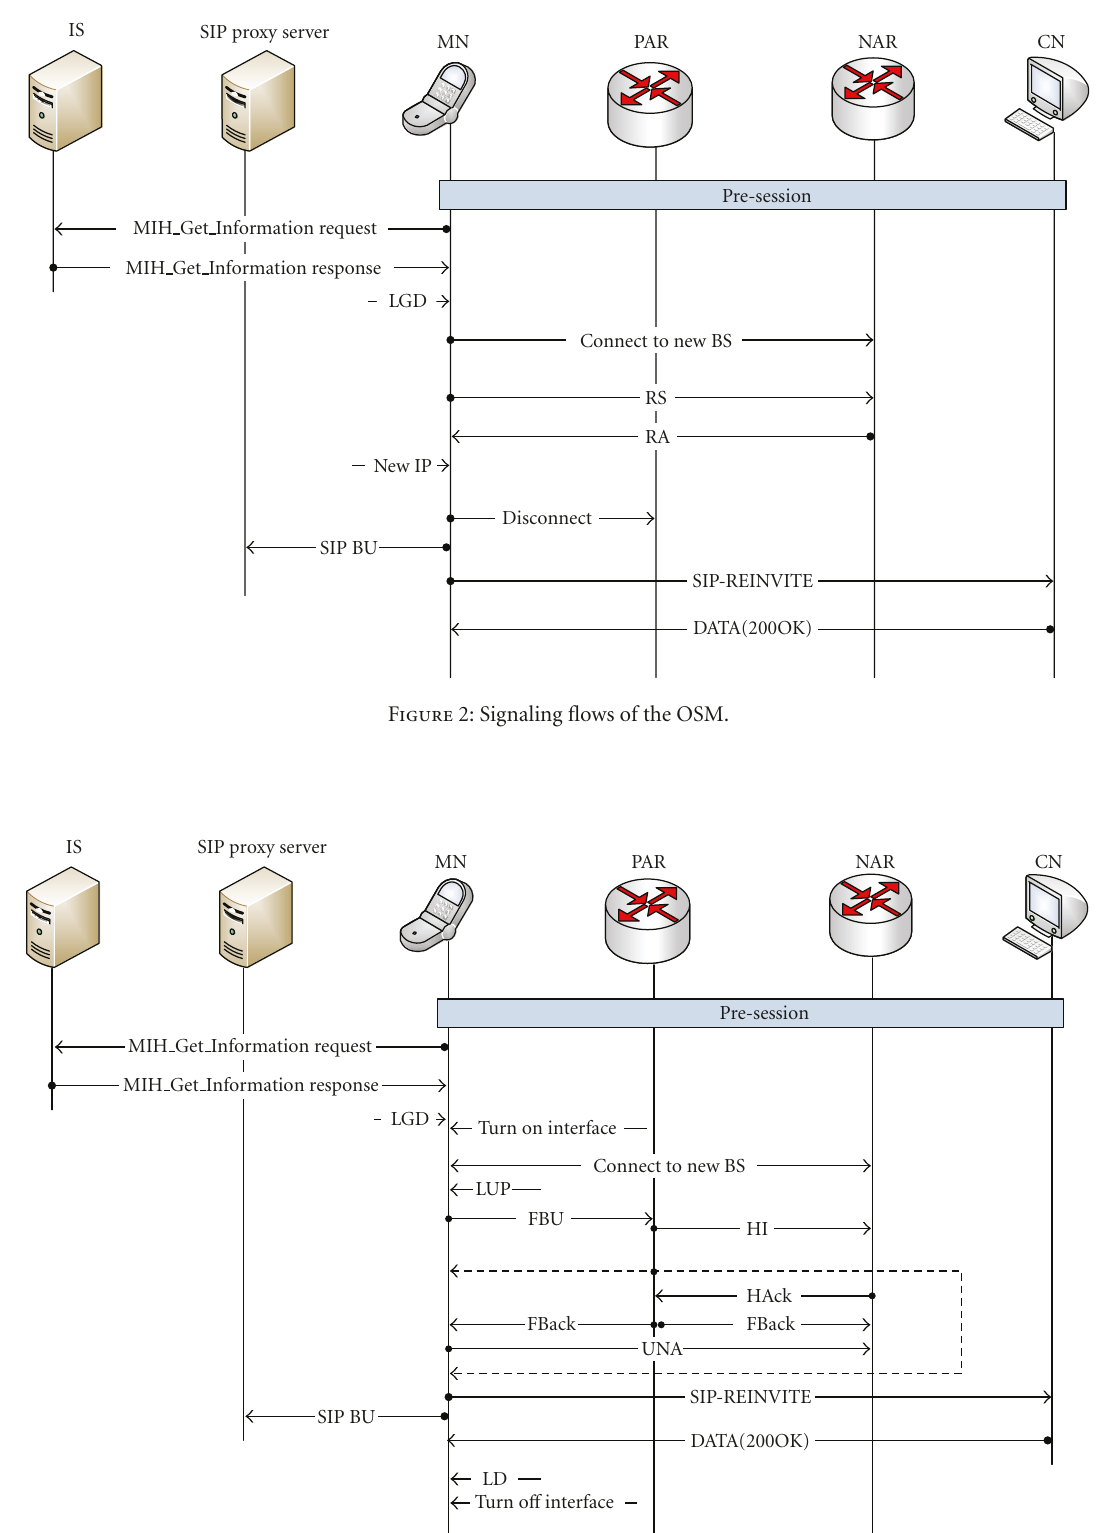
Figure 3: Signaling flows of the FASM. Dotted line depicts bu ff ering and forwarding